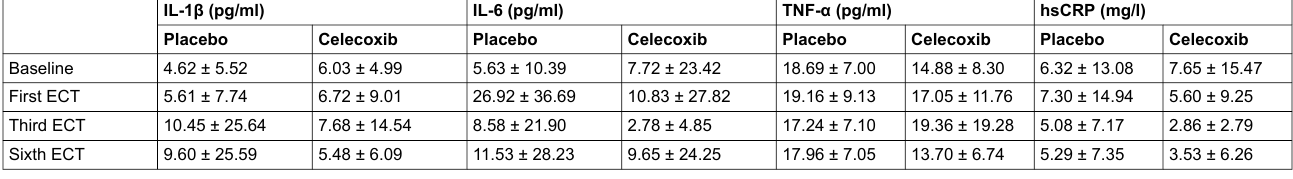
Table 2 : Serum cytokines and hsCRP concentrations in the celecoxib group (n = 25) and placebo group (n = 23) at different assessments during the study. Data are presented as mean ± standard deviation. IL-1β (pg/ml) Placebo Celecoxib Placebo Placebo Baseline